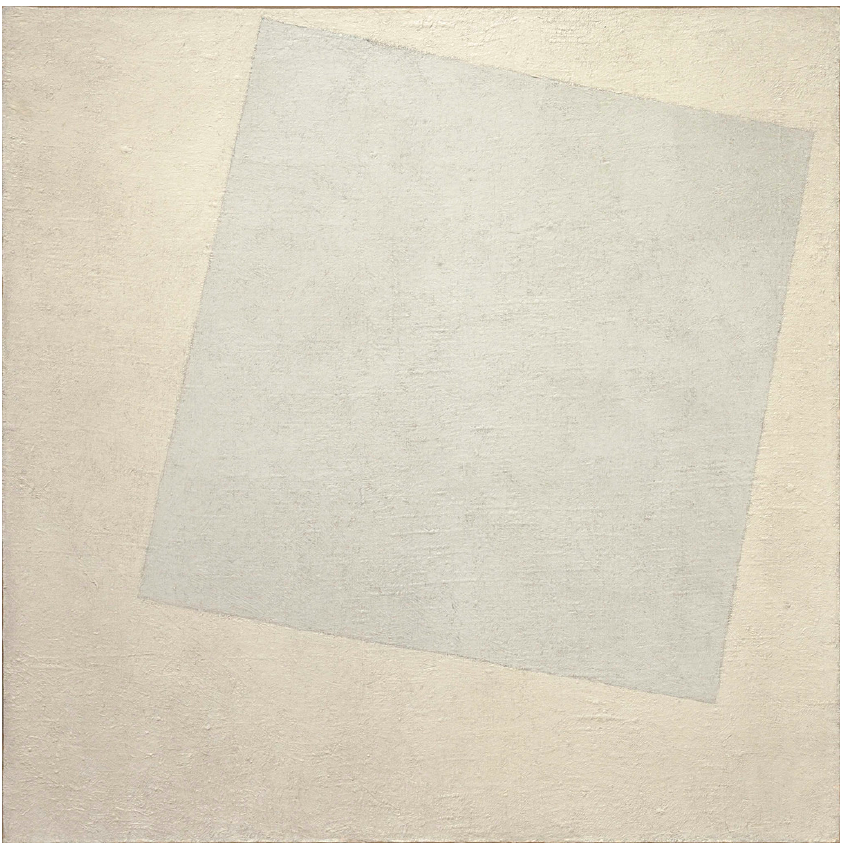
Figure 10. Kazimir Malevich. The White on White, 1918.